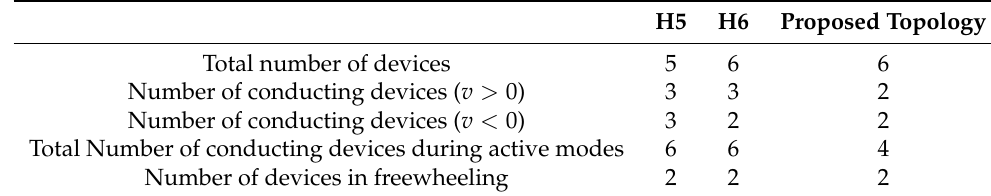
Figure 2. Proposed topology derived from H5. Table 1. Comparison of conducting devices fro different